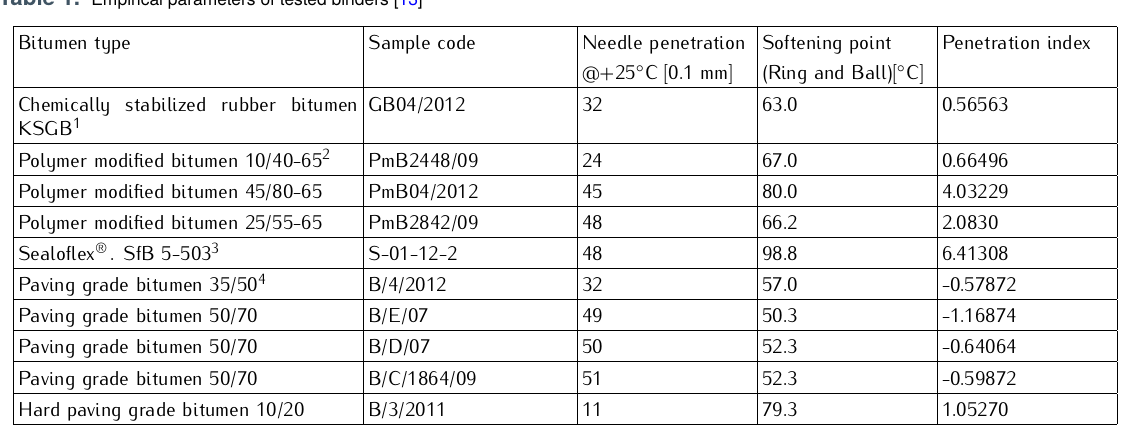
Table 1. Empirical parameters of tested binders [13]